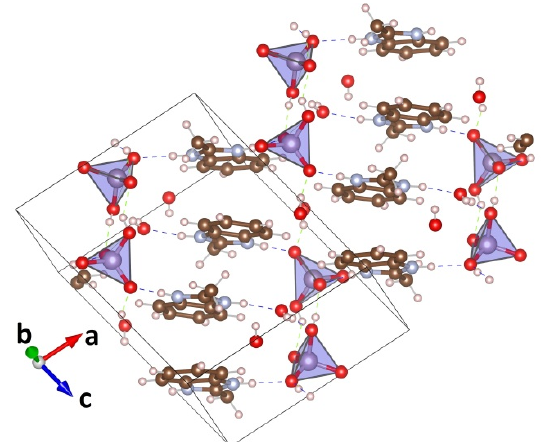
Figure 4. Crystal structure of MBI-phosphate-1 (C 8 H 9 N 2 ) 2 (H 2 PO 4 ) 2 H 2 O (red balls are oxygen atoms, brown the carbons, gray the nitrogens, white the hydrogens, lilac the phosphorus).